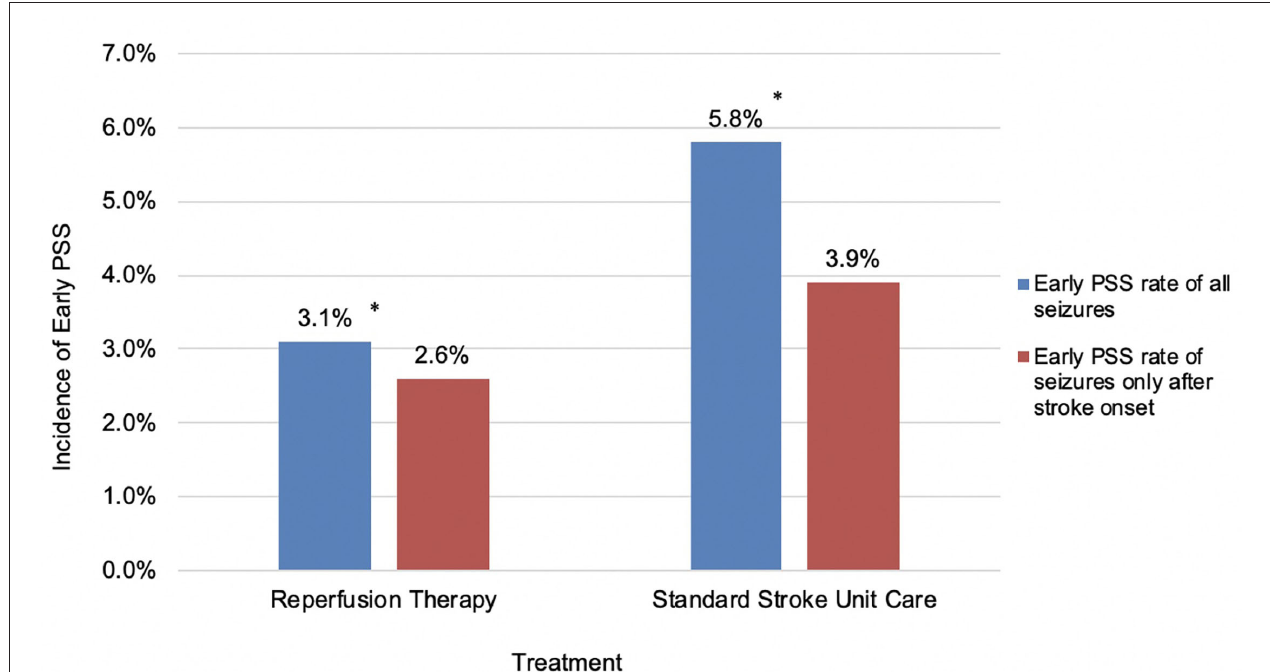
FIGURE 2 | Rates of early PSS based on treatment type.